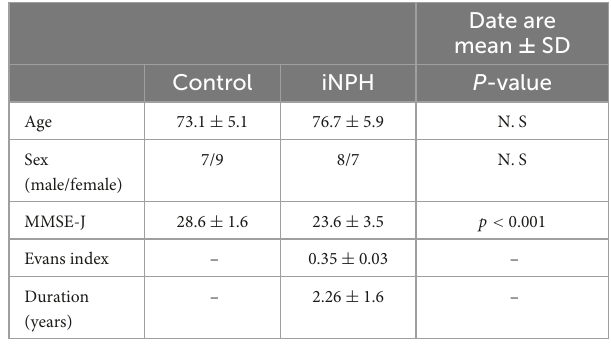
TABLE 1 Characteristics of